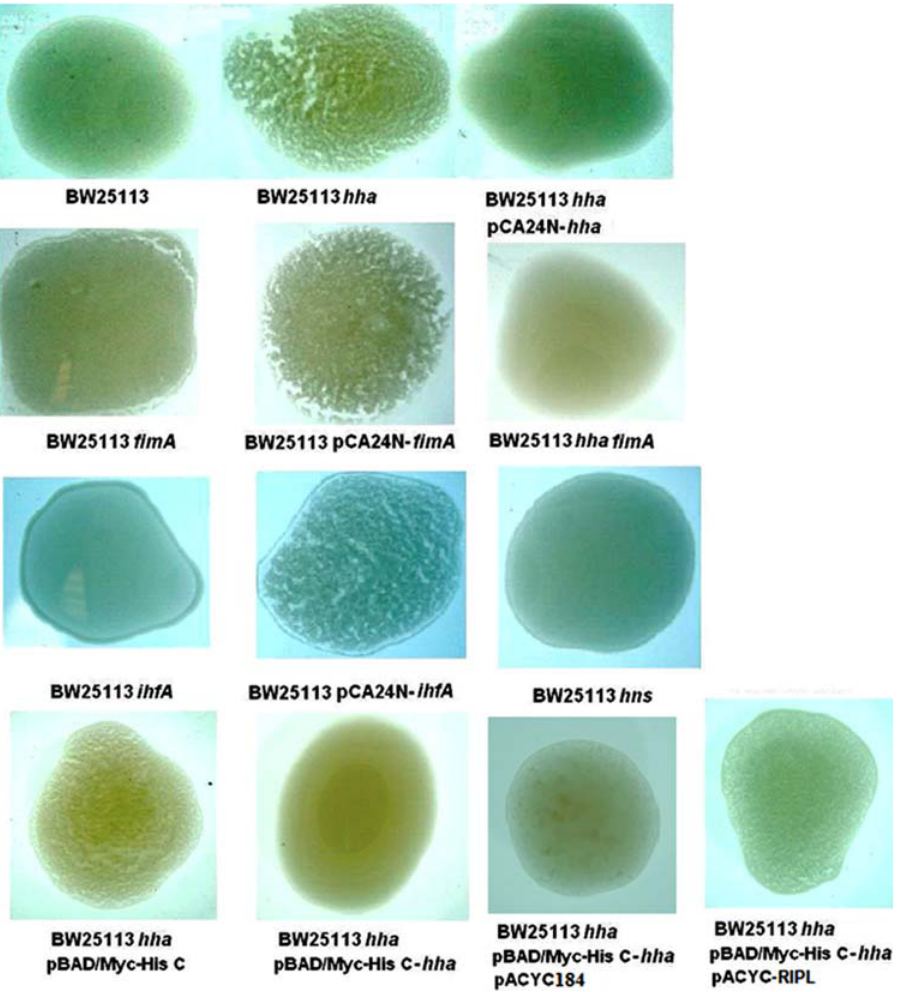
Figure 3. Hha decreases Type I fimbriae formation. Type I fimbriae were assayed via the yeast agglutination assay with various BW25113 mutants and complemented strains. pACYC-RIPL encodes extra copies of the rare codon tRNAs ileY , argU , leuW and proL , and pACYC184 is the empty vector control. The experiments were performed in triplicate.